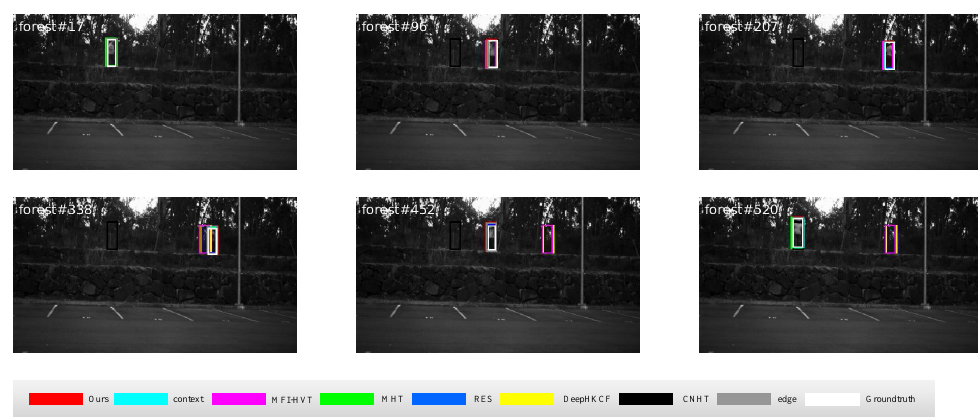
Figure 16. Qualitative outcomes for the forest sequence.